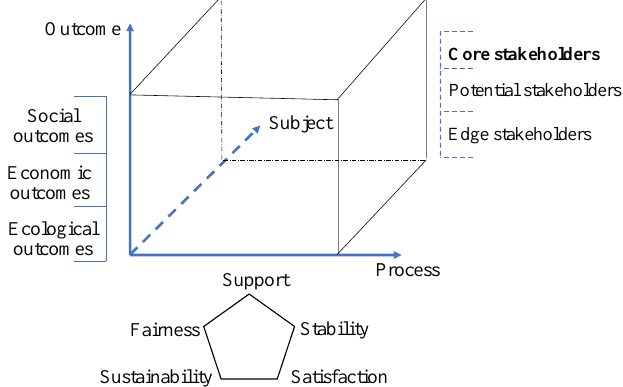
Figure 3. Illustration of the performance evaluation framework.